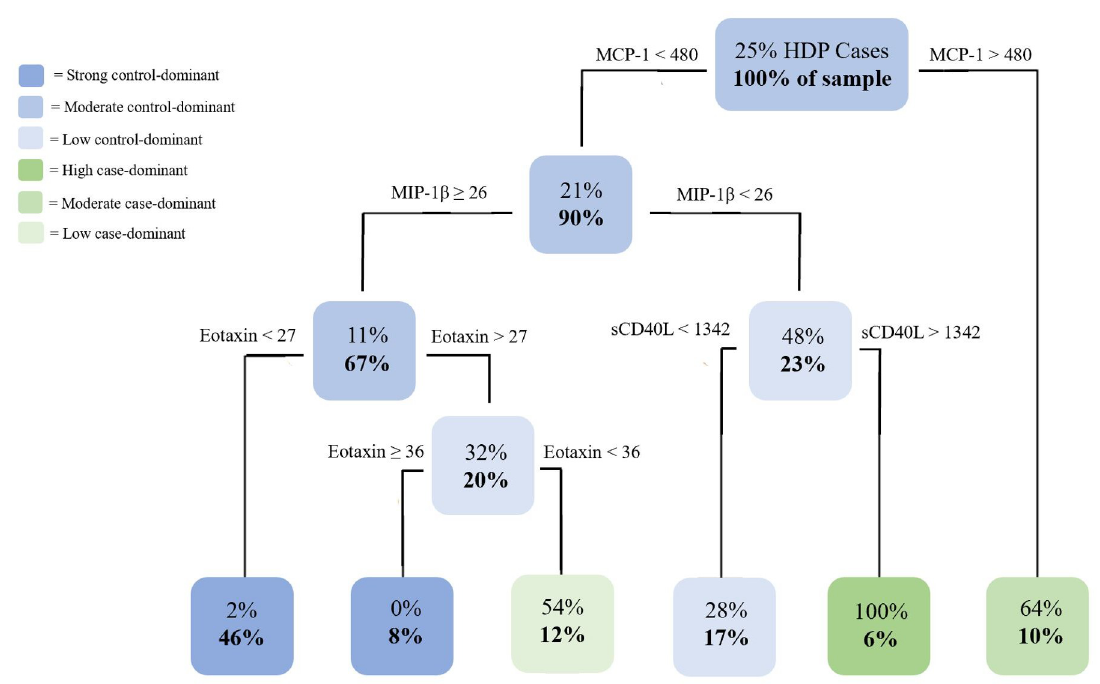
Fig 1. CART analysis of cytokine levels of participants within the HDP subset. Analysis of the HDP subset (n = 108) representing the probability of disorder diagnosis and percentage of the sample size using R software. Specific cytokines and cut-off levels (pg/mL) that are the most important in distinguishing cases versus controls were identified with colours and shading representing the likelihood of condition diagnosis.